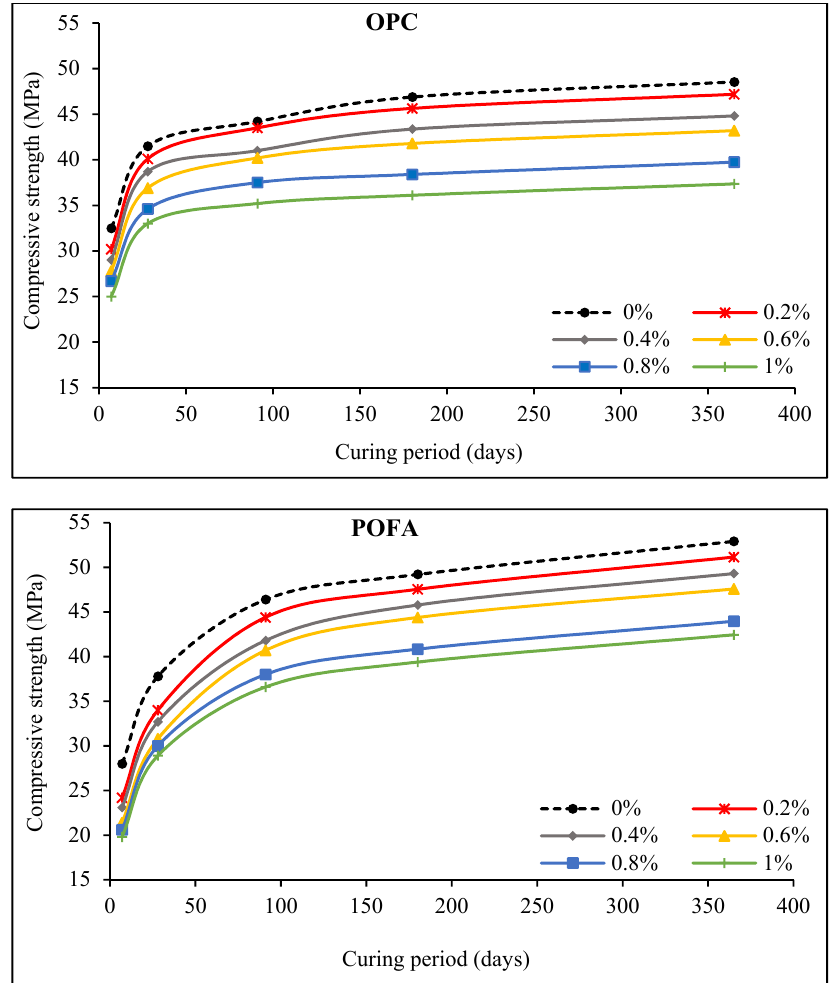
Figure 3. The variation in the water-cured compressive strength of OPC and POFA concrete mixtures containing WPFT fibers.